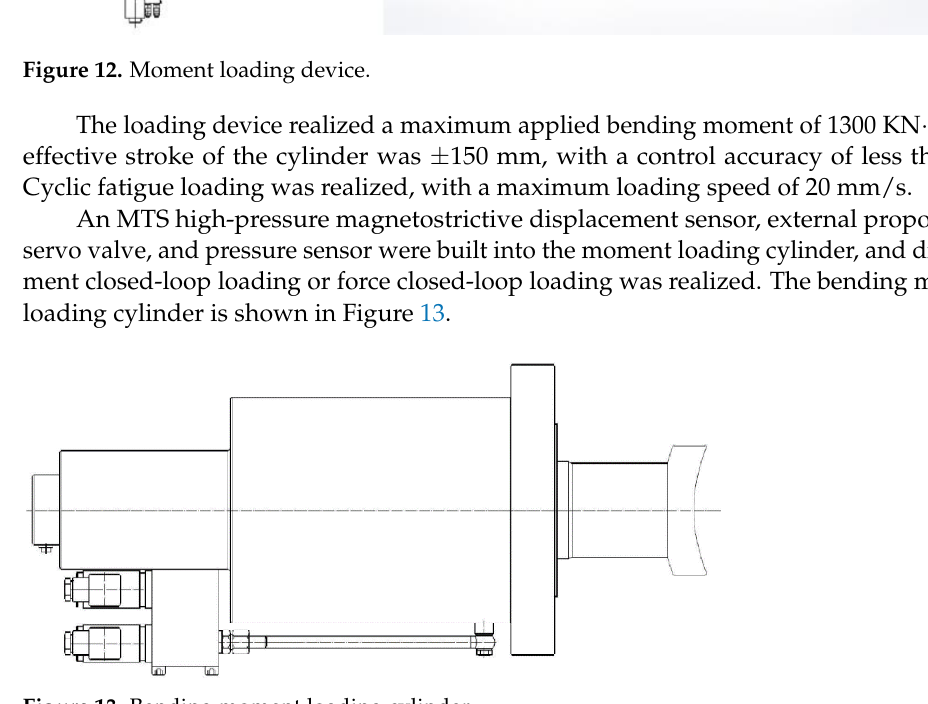
Figure 13. Bending moment loading